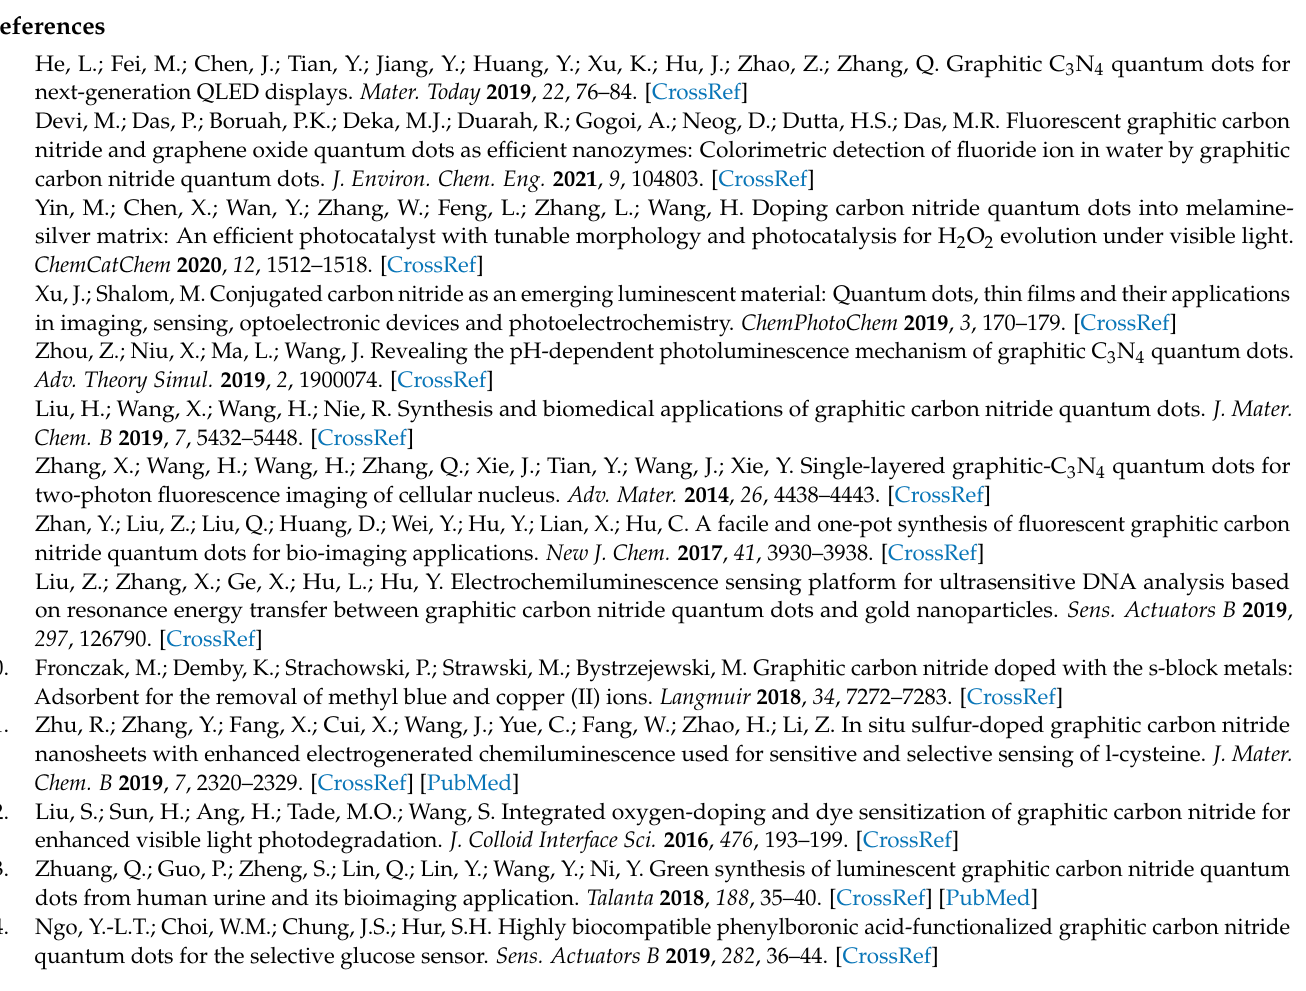
image(b) of g-C 3 N 4 . Figure S2. Fluorescence of g-C 3 N 4 QDs under irradiation by (a) visible light, and (b) 365 nm within 12 h. Table S1. The relative ratios of C-C/C-N, C-O-C, N-C=N, C=O, O-C=O, and C-CO 3 of each sample in C 1s spectral analysis. Table S2. The relative ratios of C-N=C, N-(C) 3 , C-N-H and π - π * in N 1s spectral analysis. Table S3. The relative ratios of C-O-C, C=O and COOH in each sample in O 1s spectral analysis. Table. S4. 15 groups of blank g-C 3 N 4 QDs fluorescent